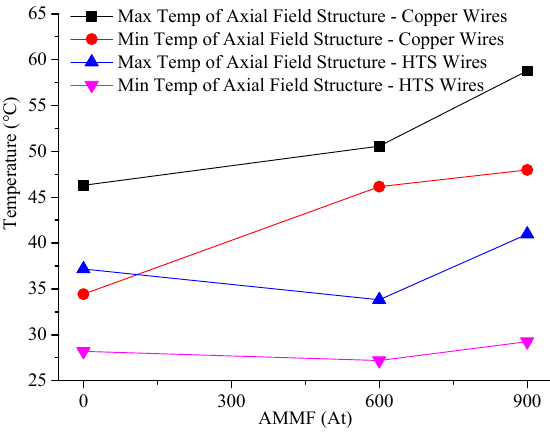
Figure 23. Comparisons of the axial field structure temperature of the machine developed by copper wires and HTS wires.